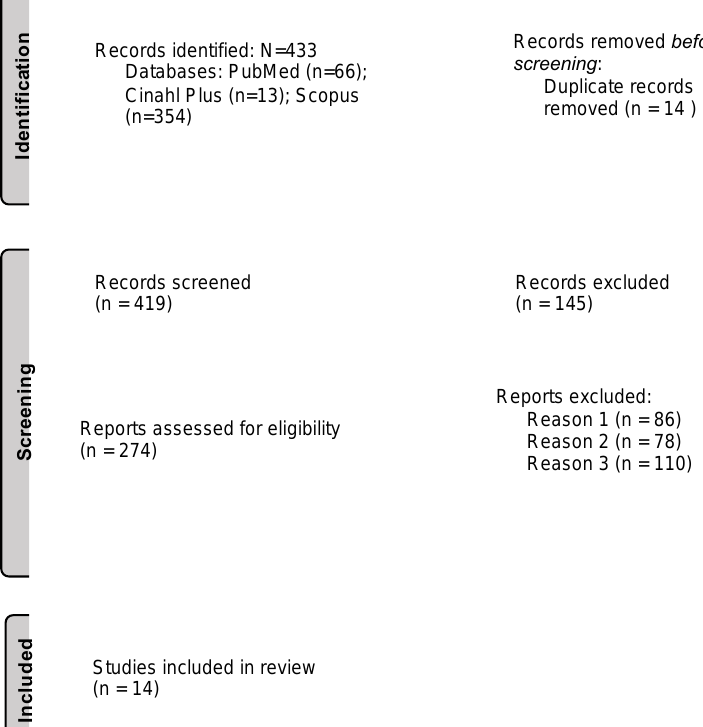
Figure 1. Flow diagram showing the search, identification and selection process for the reviewed articles and the reports excluded because of the following reasons: the work (1) does not discuss polyphenols’ action and gestational diabetes mellitus, (2) does not discuss gestational diabetes mellitus in relation to neurodevelopment and the fetus and (3) is a review. Adapted with permission from Page et al. (2021) [25].